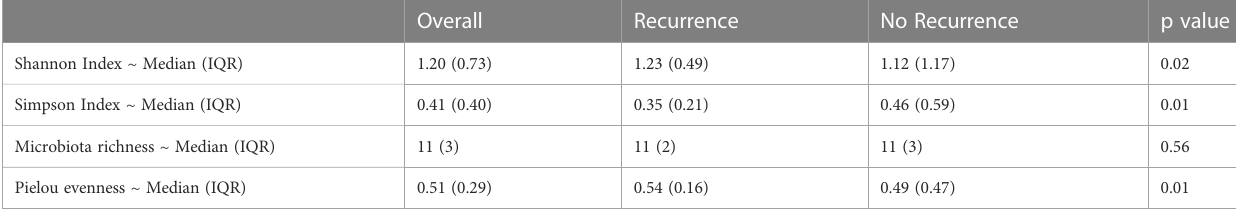
TABLE 4 Diversity measures by recurrence.